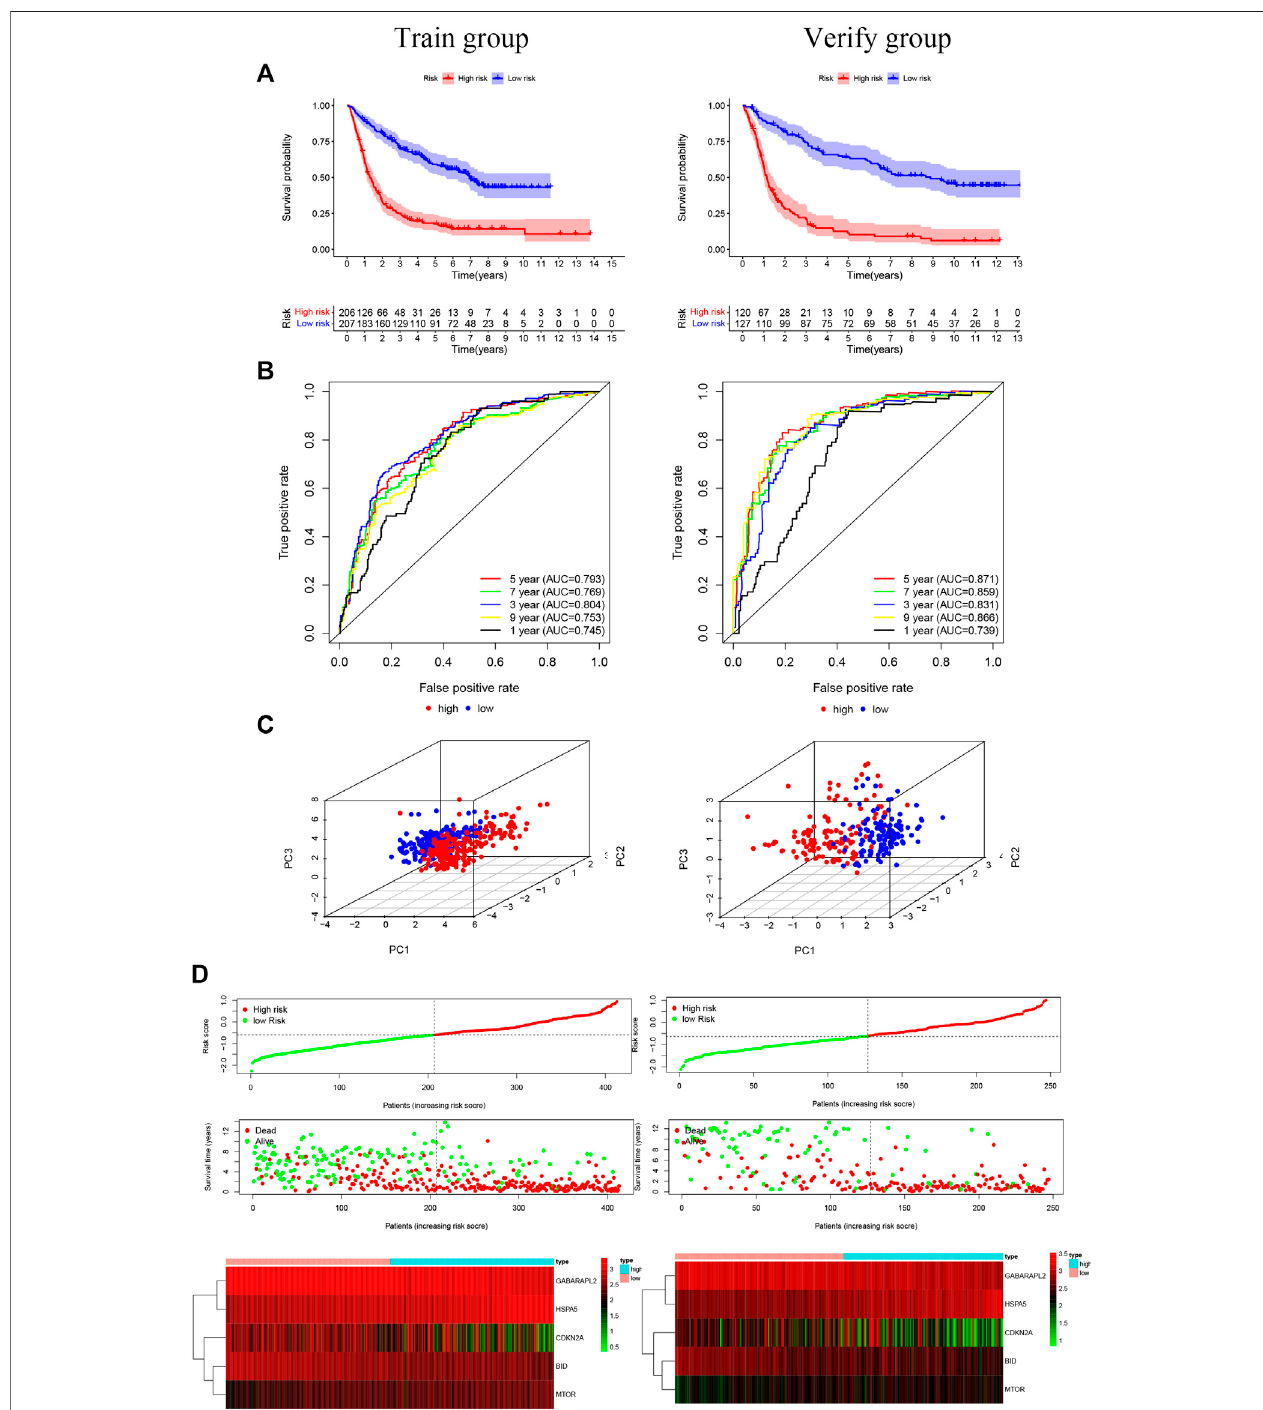
FIGURE3|(A) Theriskmodeloftheexperimental groupand thevalidation group( p < 0.001). (B) Thereceiveroperating characteristic curvesuggeststhattherisk model has good short-term and long-term predictive values between the training and veri fi cation groups. (C) Component analysis suggests that the model can accuratelydistinguishhigh-andlow-riskgroups. (D) Theriskcurveandriskstatusshowthesurvivalstatusofthepatientasthescoreincreases.Theriskheatmapshows the expression of prognosis-related genes in the high- and low-risk groups.